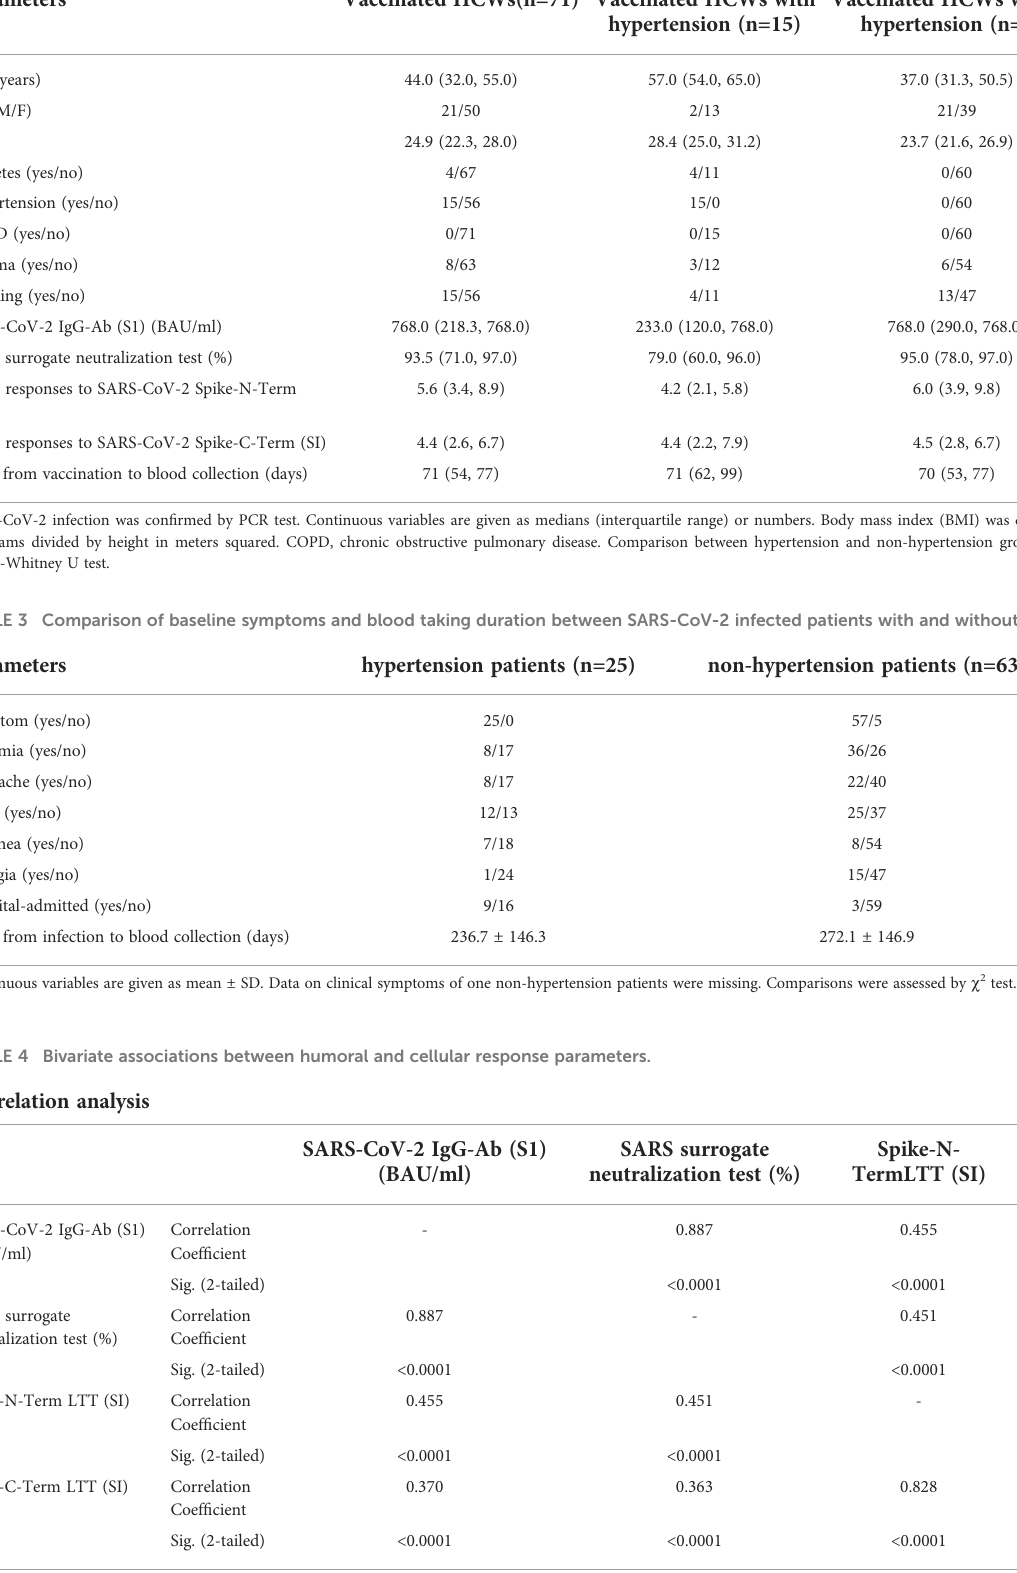
TABLE 2 Characteristics of vaccinated health care workers (HCWs).